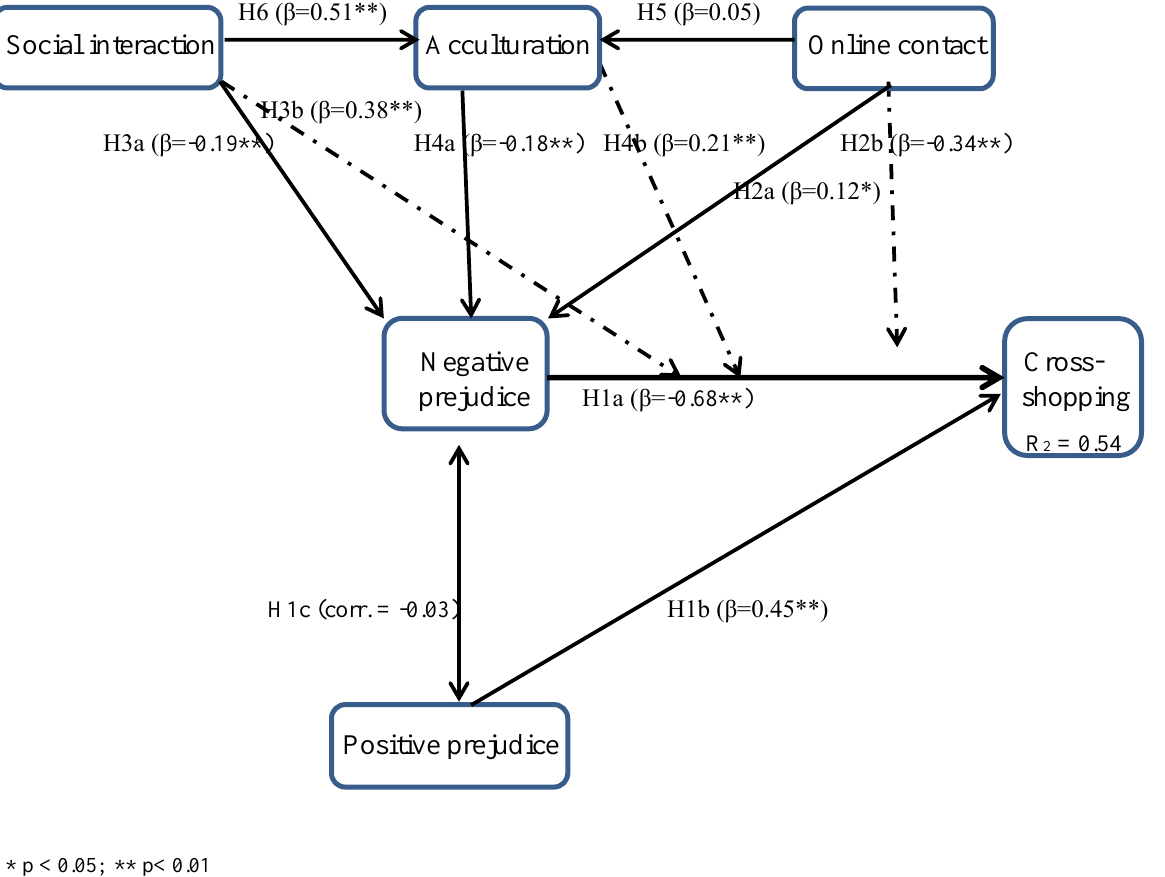
Fig. 2: Estimated theoretical